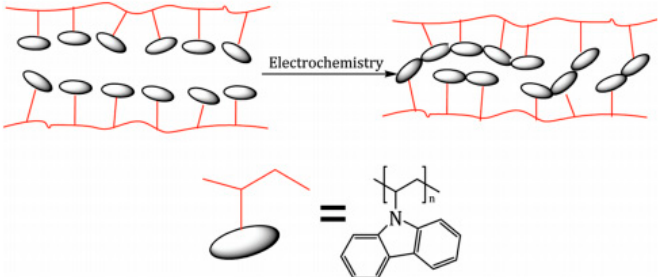
Figure 10. Schematic representation of the precursor polymer approach to CPN films. Reproduced with permission from Frau et al. [133]. Copyright (2010) American Chemical Society.